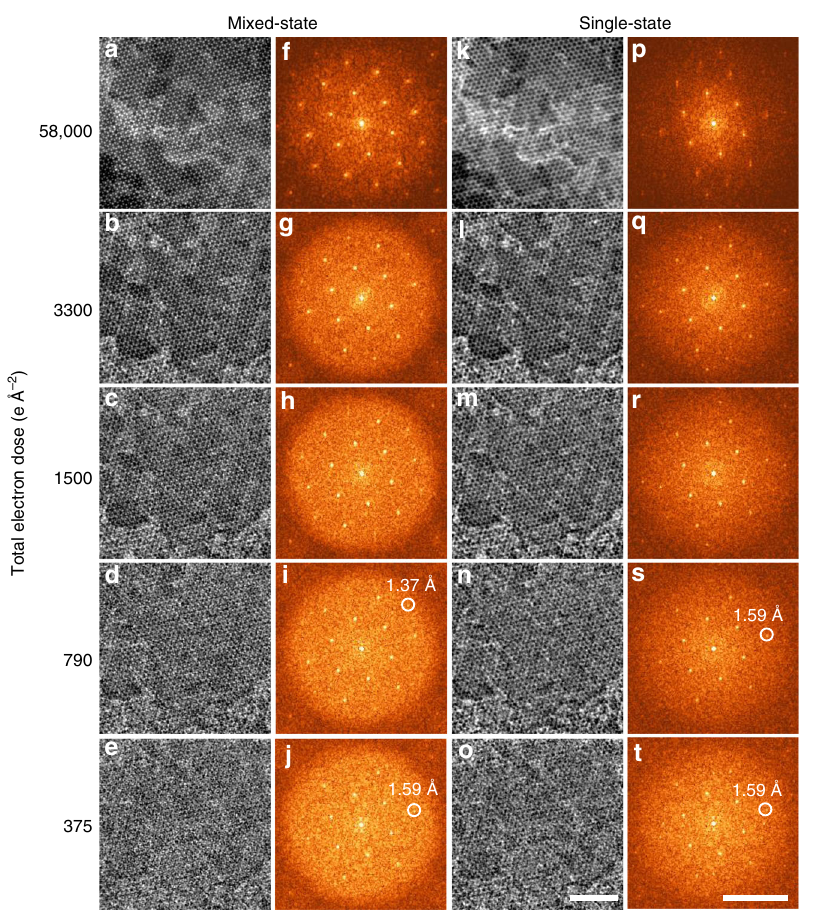
Fig. 4 Ptychographic reconstructions of a monolayer WS 2 sample in different illumination dose conditions. a – e Reconstructions by mixed-state ptychography using doses 58,000, 3300, 1500, 790, and 375 e Å − 2 , respectively. k – o Reconstructions by single-state ptychography. f – j , p – t Corresponding diffractograms of the reconstructions. Scan step size is 0.85Å for doses from 790 to 58000 e Å − 2 . For the dose of 375 e Å − 2 , the dataset is selected in an interval of two from the dataset with a dose of 1500 e Å − 2 and the scan step size is 1.69 Å. Three probe modes were used in mixed-state ptychography. The real-space distance of the representative diffraction spots is labeled on i , j and s , t . The non-uniform contrast in the reconstructed images comes from the polymer residual during the sample preparation. Scale bars for real-space images in a – e and k – o are 3 nm, and for diffractograms in f – j and p – t are 0.7Å − 1